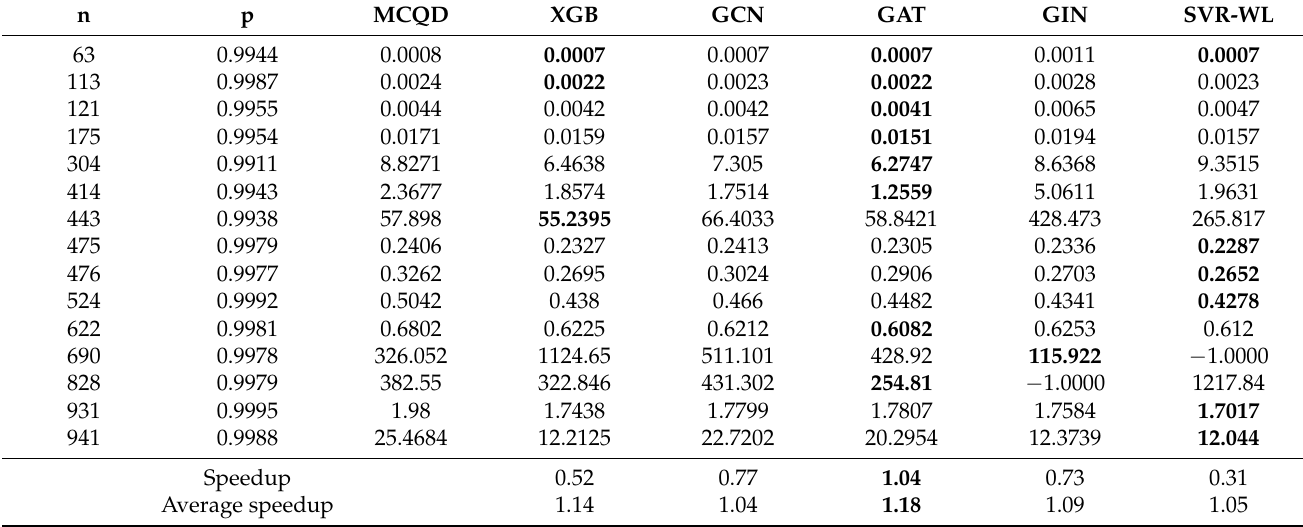
Table 3. Times needed by algorithms to find the maximum clique for each graph in a test set of dense random graphs. Best times are in